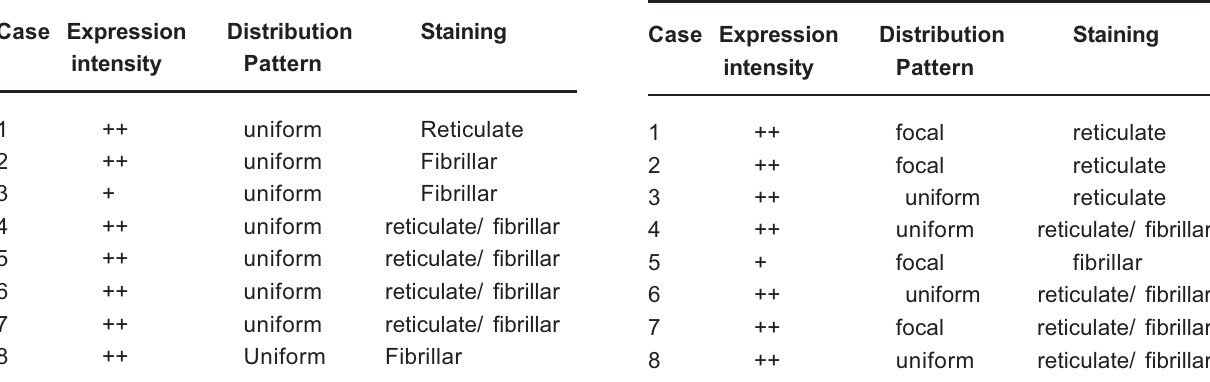
TABLE 1 - Fibronectin expression intensity, distribution and staining pattern in interstitial extracellular matrix of the central giant cell granulomas of the jaws